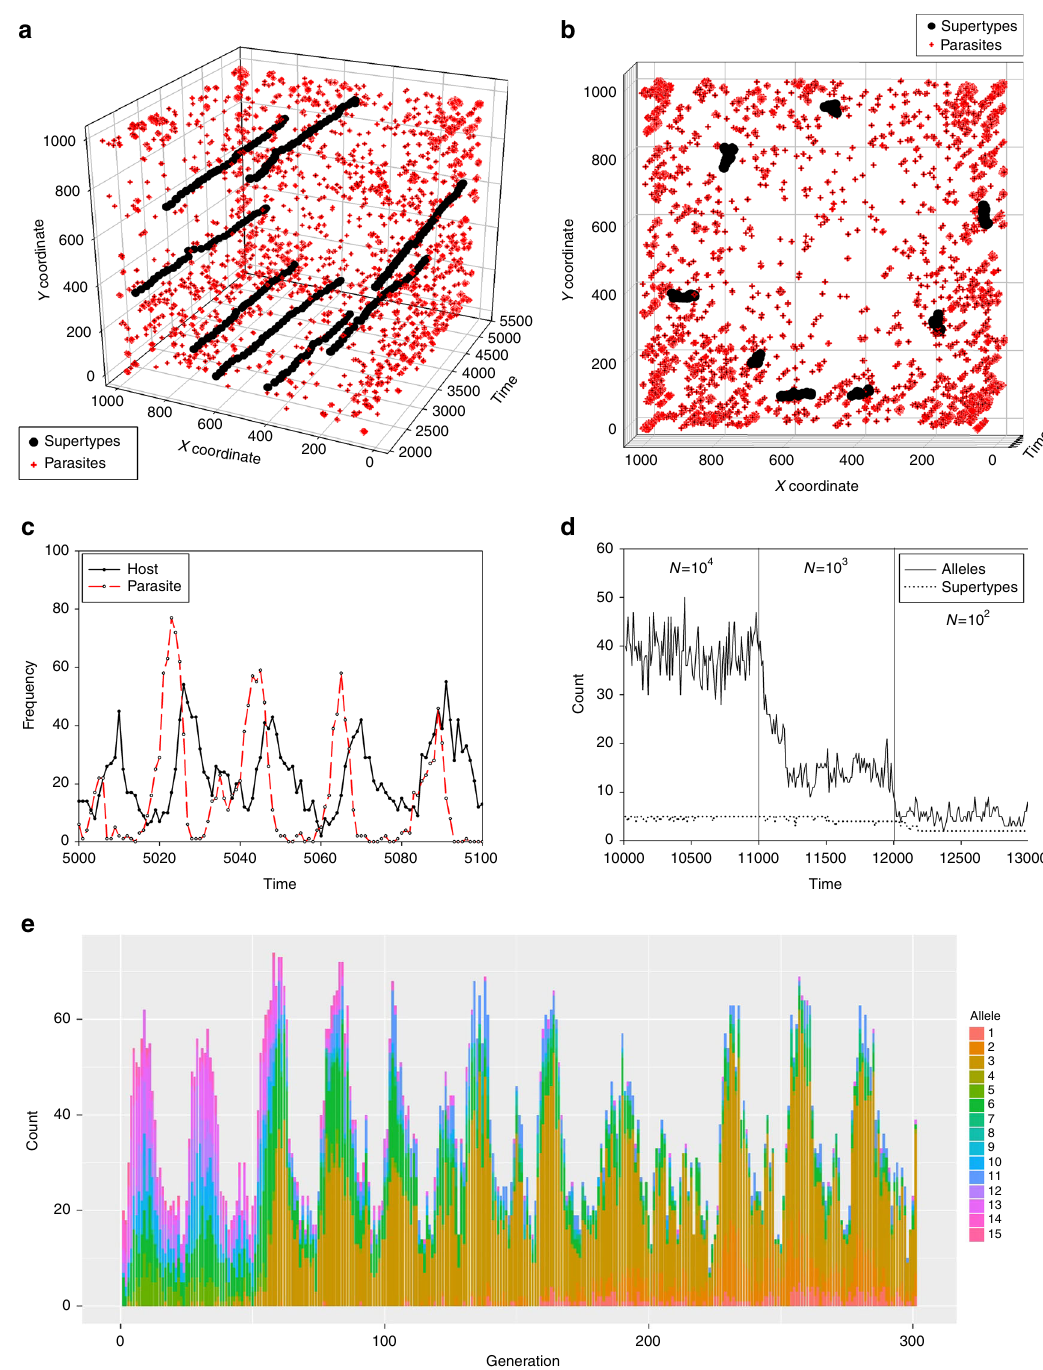
Fig. 4 Computer simulations of host – parasite co-evolution. The centroid position of each supertype (ST) is indicated by the black dots and red crosses for parasites. Shown are simulations of a one locus model with N = 10,000 host population size, and mutation rate µ = 0.1. Eight STs evolve. a Each ST shows little change within the epitope/paratope space ( XY coordinate) over time ( Z -axis), which is consistent with trans-species polymorphism. b A two- dimensional view shows that STs ‘ wobble ’ in epitope/paratope space over time. c A dynamic co-evolutionary equilibrium between ST and parasite frequencies is driven by negative frequency-dependent selection, consistent with the Red Queen dynamics. d The number of alleles is more strongly affected by demographic processes (population sizes of N = 10 4 , 10 3 and 10 2 ) than the number of STs. e Frequencies of alleles within a single ST show a classic Red Queen arms race with alleles replacing one another over time, consistent with recurrent bouts of positive selection. STs remain preserved over evolutionary time, despite the Red Queen arms race and the high turnover of their constituent alleles (see ‘ Results ’ section, cf. divergent allele advantage hypothesis by Wakeland et al. 21